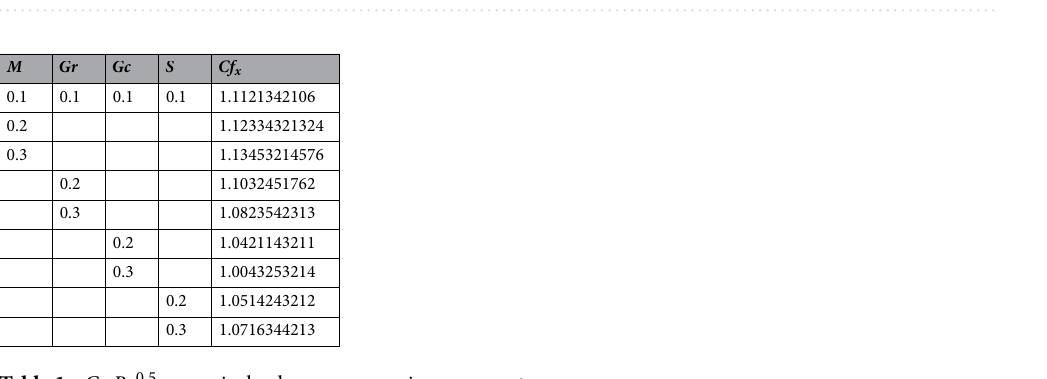
Figure 18. % Wise change in the mass transfer rate due to the variation In parameters Nt , Nb , S and Sc . When M = 0.3, Pr = 6.2 .